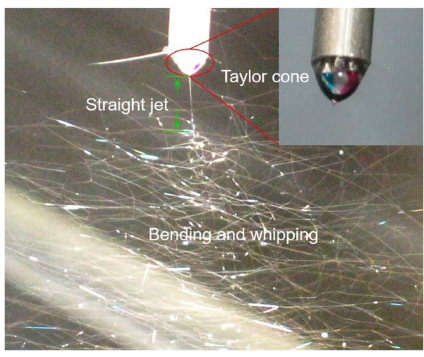
Figure 2. Digital image of the advanced, multi-fluid electrospinning process, including Taylor cone, jet, and bending. The inset picture shows the visualization process by dyeing the two healing